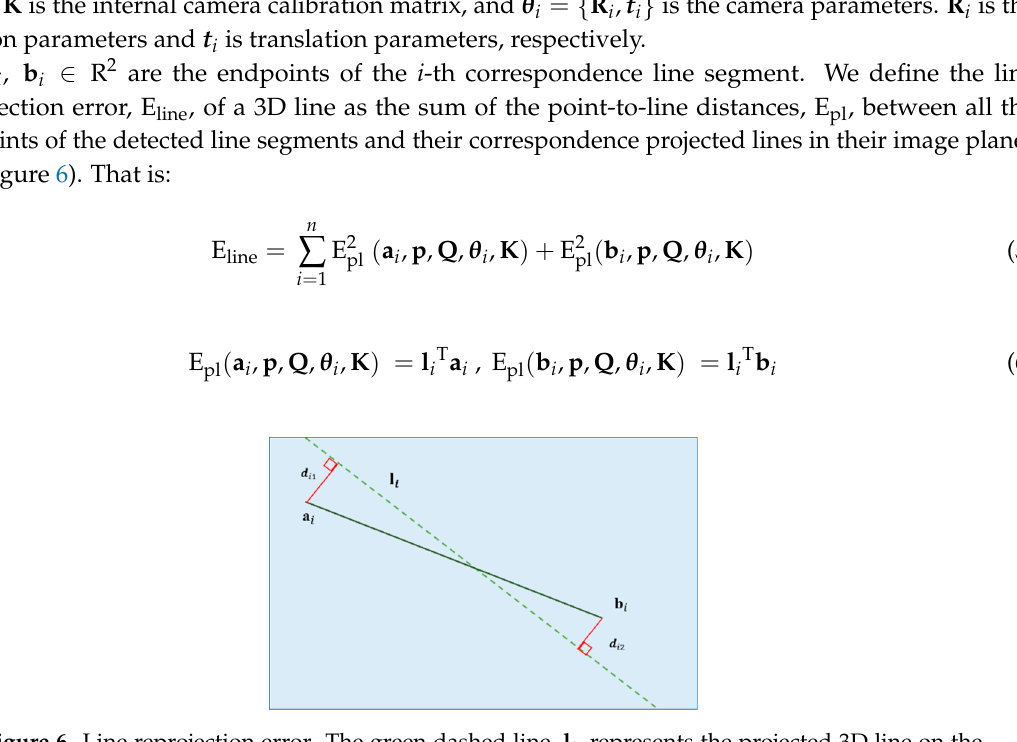
Figure 6. Line reprojection error. The green dashed line, l i , represents the projected 3D line on the image plane. a i , b i are the endpoints of the i -th correspondence line segment. Red lines, d i 1 and d i 2 , are the line reprojection error between a projected 3D line (green dashed) and the corresponding detected 2D line (green solid). The line-based reprojection error of a 3D line is the sum of the line reprojection error of all the correspondence line segments.